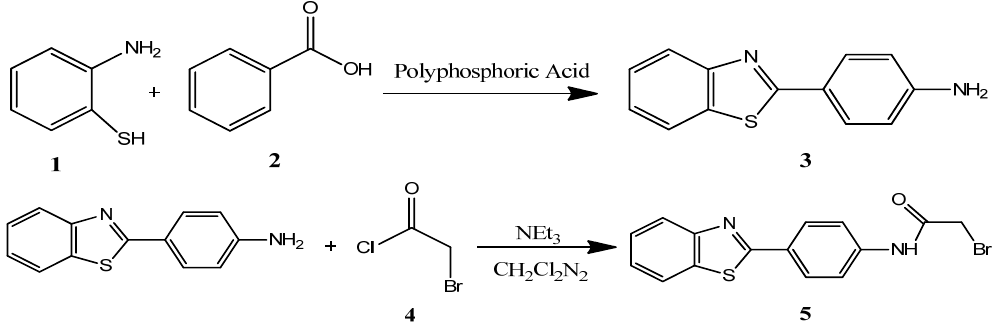
Figure 11. Synthesis scheme for 2-(4’-aminophenyl)benzothiazole (ABT, 3 ) and compound 5 .